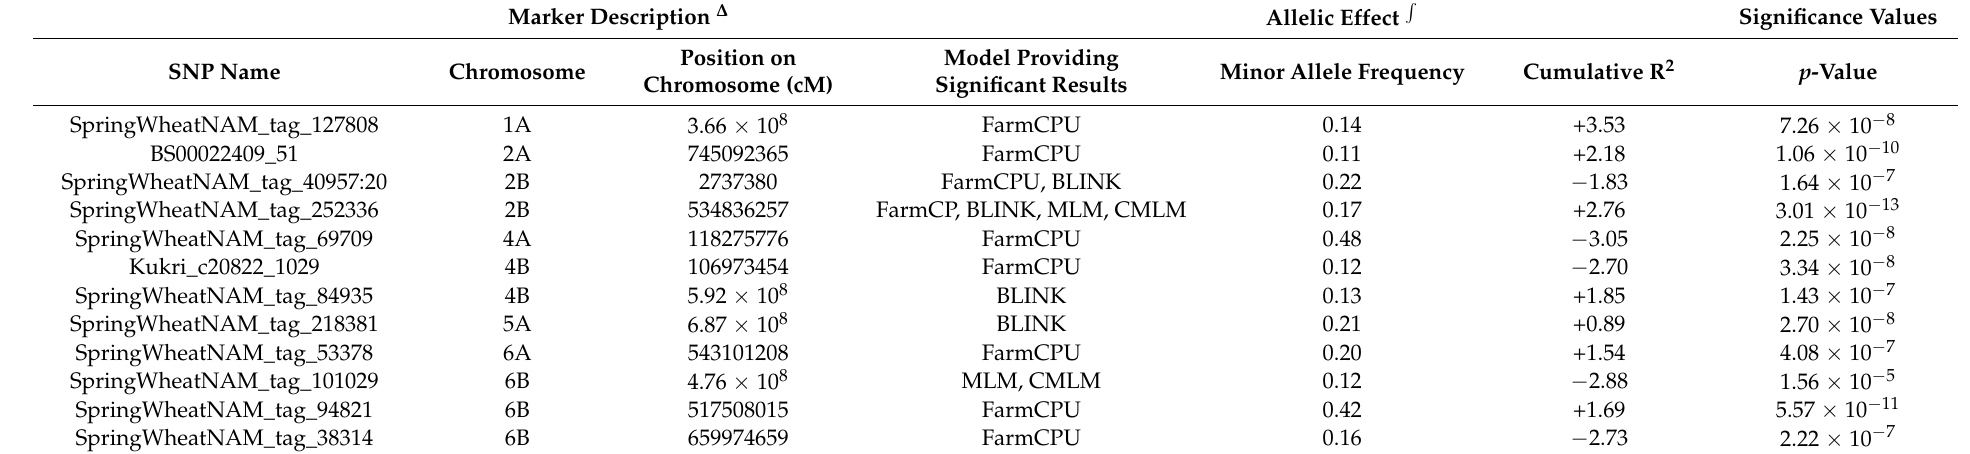
Table 3. Significant markers representing quantitative trait loci for grain protein content deviation in a nested association mapping of hard spring wheat. Marker Description ∆ Allelic Effect